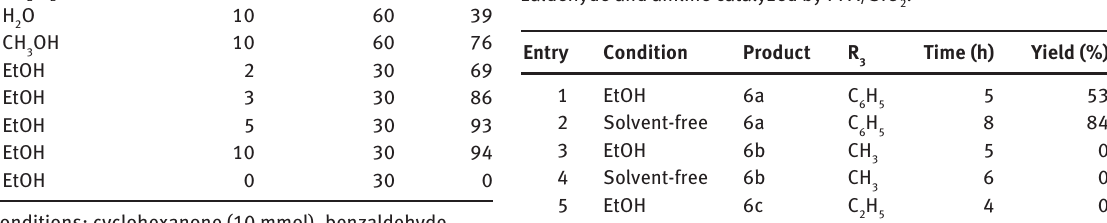
Table 3 Three-component Mannich reactions of ketones with